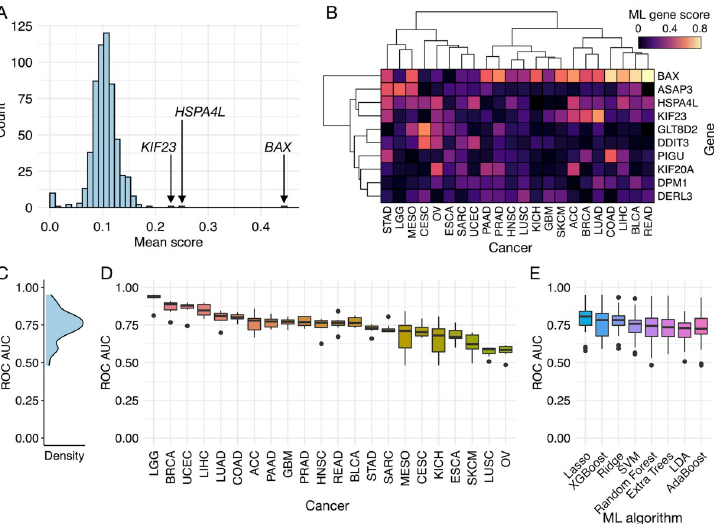
Fig 2. Identification of PSP genes associated with p53 mutation. ( A ) Histogram of ML gene scores averaged across all cancer types, with the top 3 scoring genes labeled. ( B ) Heatmap of the ML gene scores for each cancer type, showing only the top 10 scoring genes on average across cancer types. ( C ) Density histogram of all ROC AUC values for each ML algorithm and cancer type. Boxplots of ROC AUC values grouped by ( D ) cancer type or ( E ) ML algorithm.